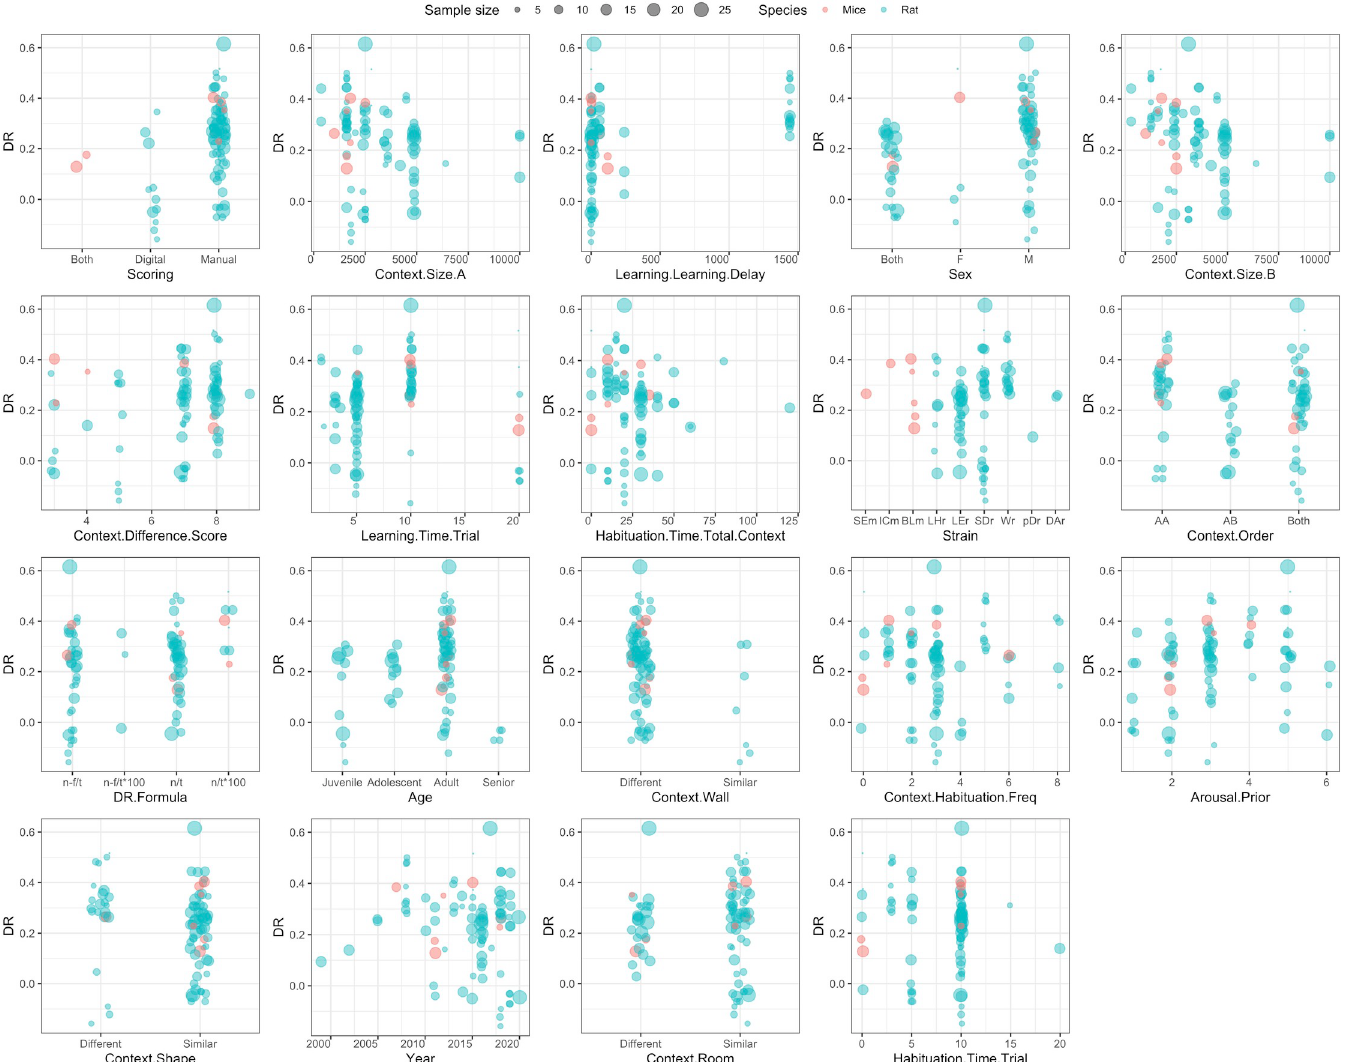
Fig 8. Weighted scatter plots showing the distribution of the raw DR for the 50% most important variables in the random forest-based meta-analysis, broken down by species: Mice in red vs. rat in blue. Dot size indicates the sample size of each observation. Most studies were performed in rats. The y-axis shows the mean DR and x-axis shows the values of the variable that is named below the graph. The values of context.size A and B are shown in in cm 2 and the values of time variables (learning. learning.delay, learning.time.trial, habituation.time.total.context, habituation.time.trial) are shown in minutes. Higher context.difference.score values indicate more different contexts and higher arousal.prior values indicate more arousal prior to the experiment. Strains values are abbreviations: TMm (Tg(Sim1cre)KH21Gsat/ Mmucd mice), SEm (SEm Sv/Ev mice), ICm (ICR mice), BLm (C57BL/6 mice), LHr (Lister hooded rats), LEr (Long-Evans rats), SDr (Sprague-Dawley rats), Wr (Wistar rats), pDr (pigmented DA strain rats), DAr (Dark Agouti rats). DR.formula values are also abbreviations: n-f/t ((T novel -T familiar )/(T novel +T familiar )), n-f/t � 100 ([(T novel - T familiar )/(T novel +T familiar )] � 100), n/t ((T novel )/(T novel +T familiar )), n/t � 100 ([(T novel )/(T novel +T familiar )] � 100). The context.order value AA indicates that memory was tested in the context of the second learning trial, the value AB indicates that memory was tested in the context of the first learning trial, ‘both’ indicates that AA and AB were randomized. Finally, context.habituation.freq values show the number of visits per context. Full definitions of variables and sum scores can be found in A2 and A5 Appendices in S1 File respectively.